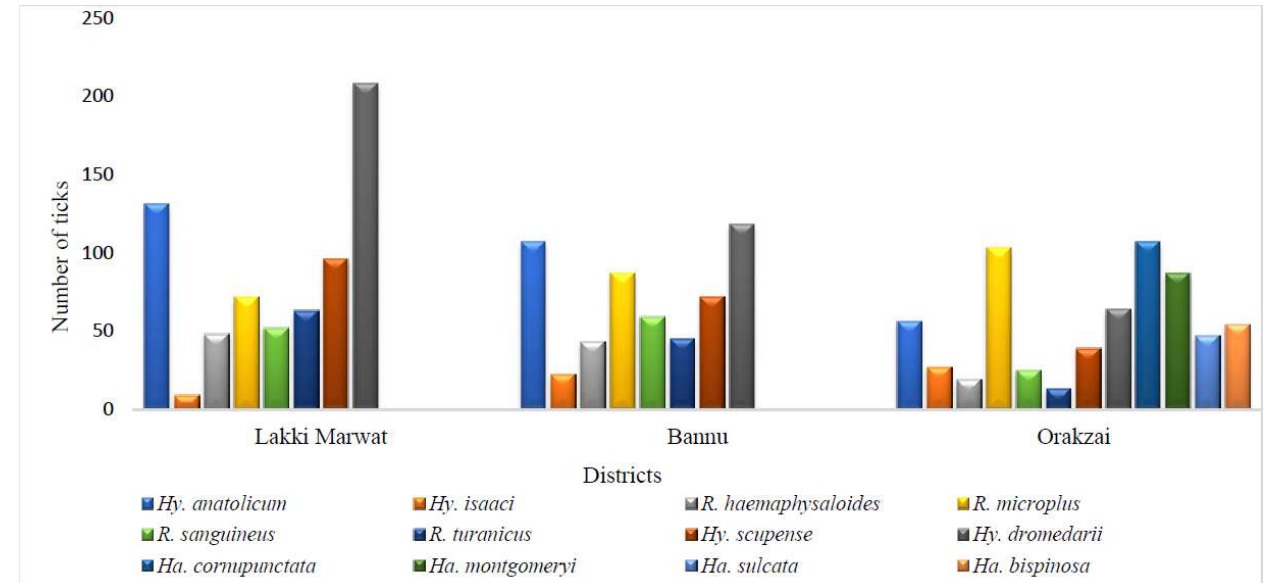
Microorganisms 2022 , 10 , 1663 Figure 3. Spatial patterns of the collected ixodid ticks in the study regions. Figure 3. Spatial patterns of the collected ixodid ticks in the study regions.